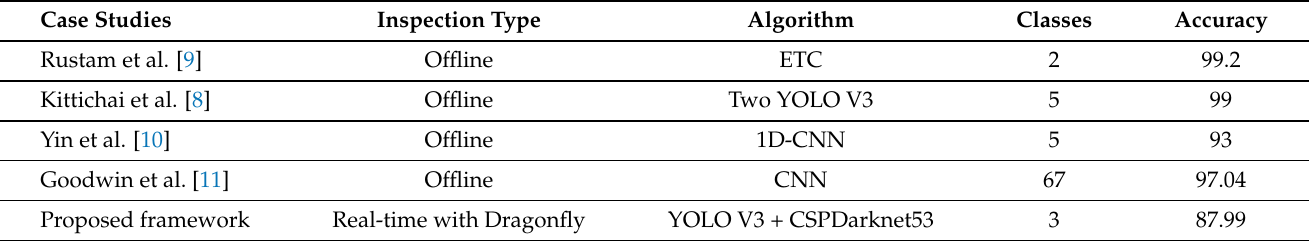
Table 7. Comparison analysis with existing object detection